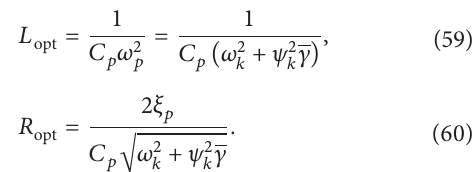
, the solid lines refer to 𝜉 𝑘 low (see Table 4). high